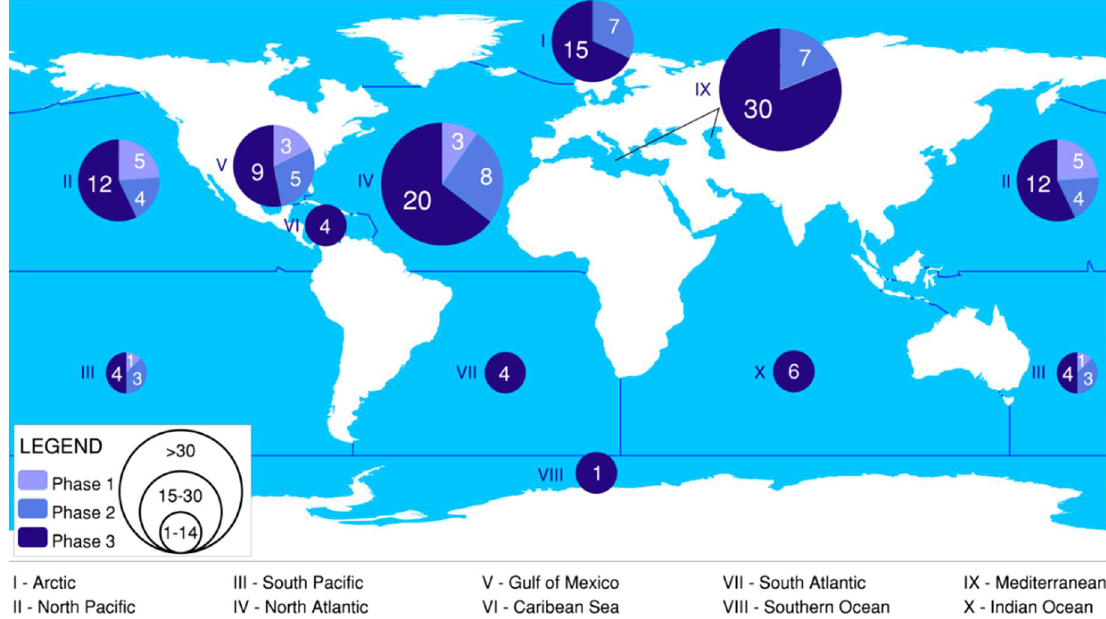
Figure 5. Number of peer-reviewed publications by oceans and seas between 1982 and 2016.